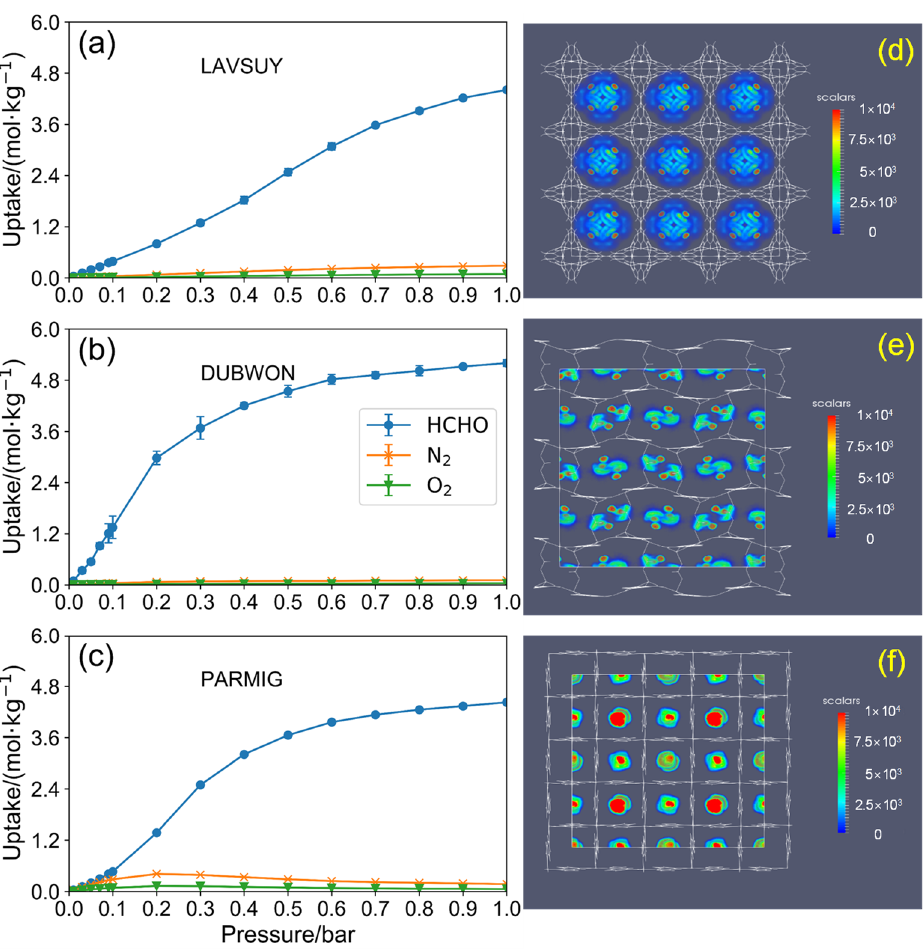
Figure 4. Formaldehyde, N 2 and O 2 adsorption isotherm of top-performing MOFs for a mixture component of HCHO/N 2 /O 2 = 2/798/200 from GCMC simulation at 298 K (( a ) for LAVSUY, ( b ) for DUBWON, ( c ) for PARMIG). The density distribution of formaldehyde adsorbates in ( d ) LAVSUY, ( e ) DUBWON and ( f ) PARMIG.